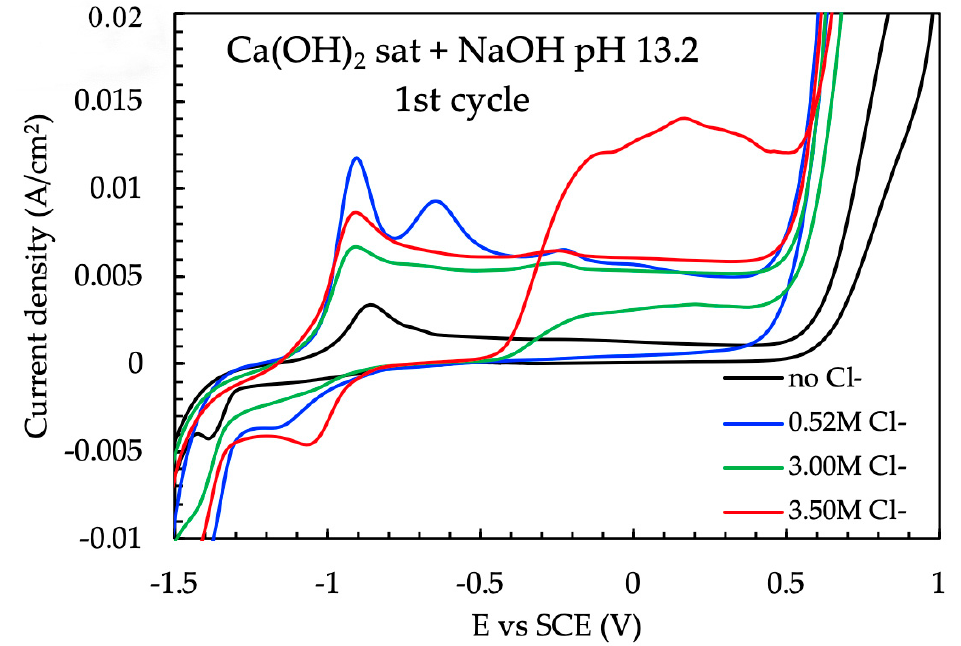
Figure 9. Effect of chloride ions concentration on the first cycle of the voltammetric curves of steel in saturated Ca(OH) 2 solution at pH 13.2 and tartrate ions in a concentration of 1 M.